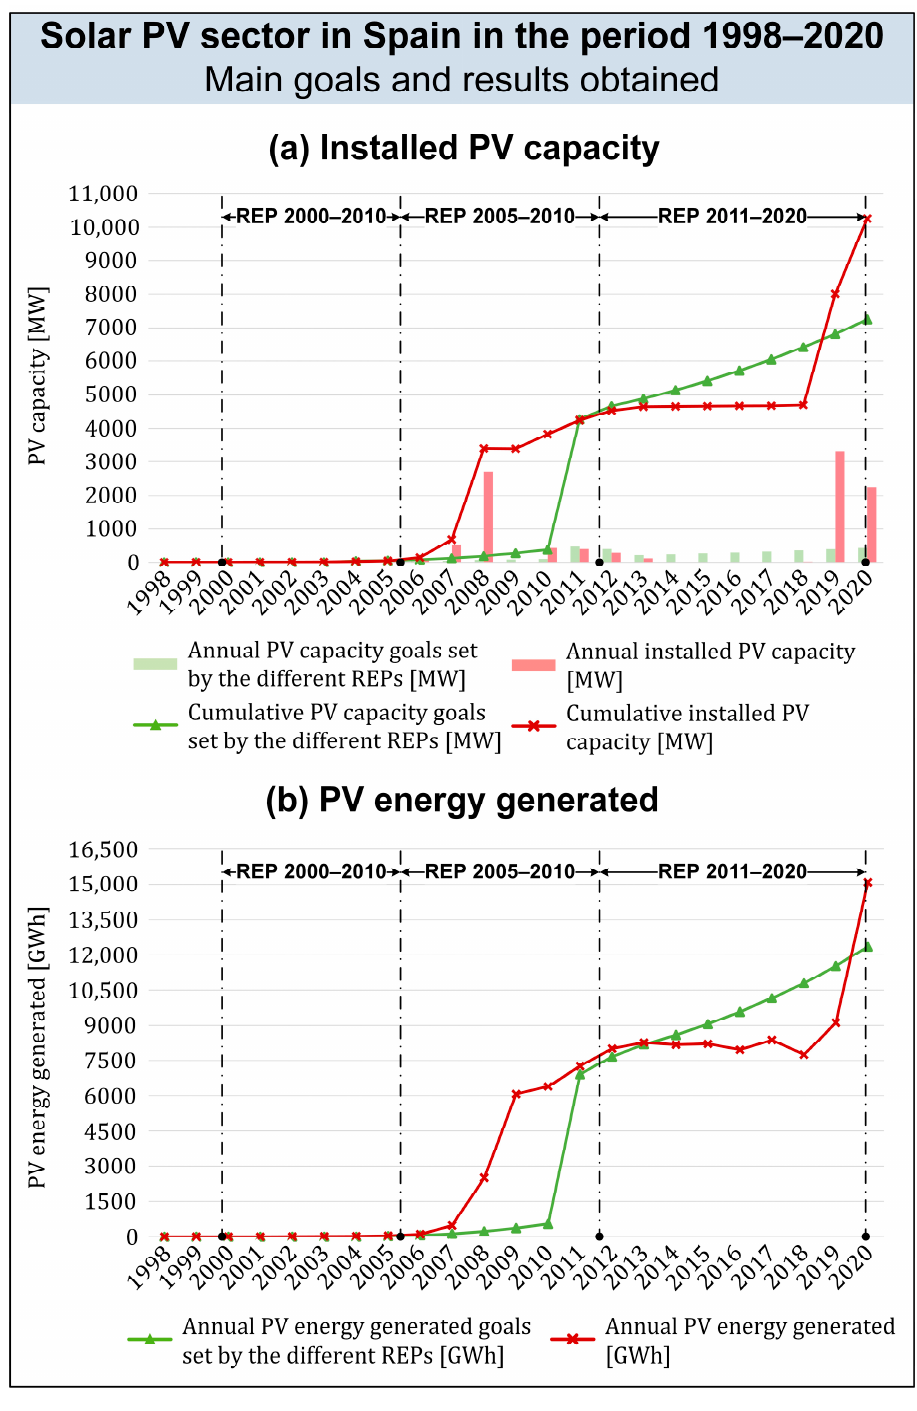
Figure 1. Evolution of the solar PV sector in Spain in the period 1998–2020 in terms of: ( a ) installed PV capacity; ( b ) PV energy generated. Source: self-elaboration based on [62,66,68,69].